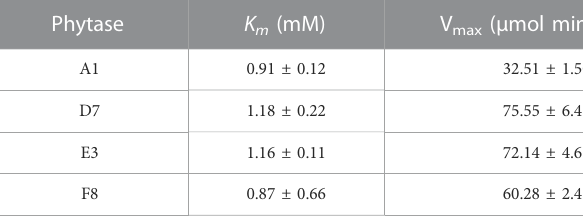
TABLE 3 Kinetics of parent and D7, E3, F8 a .